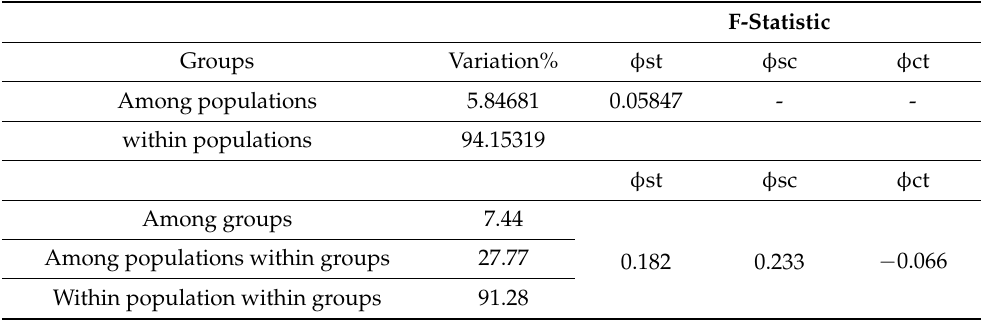
Table 2. AMOVA of ITS, GAPDH and TEF- 1α sequences for geographic and haplogroups of B. so- rokiniana.